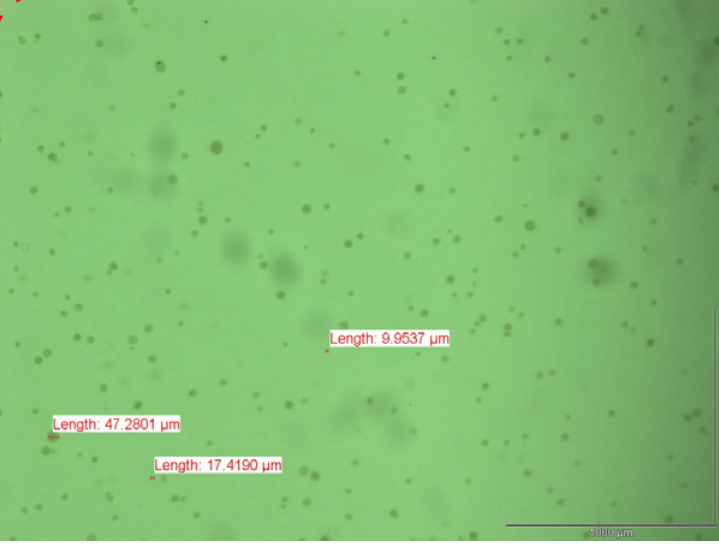
Figure 8. Microscopic photos for FWM-CV after ultrasound treatment.